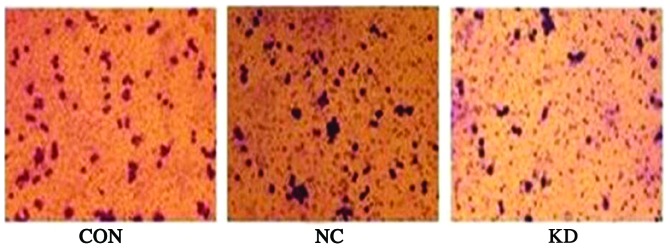
Cell invasion assay by Transwell method Stained with crystal voolet. (Magnification, ×100). CON, control; NC, negative control; KD, interference group.